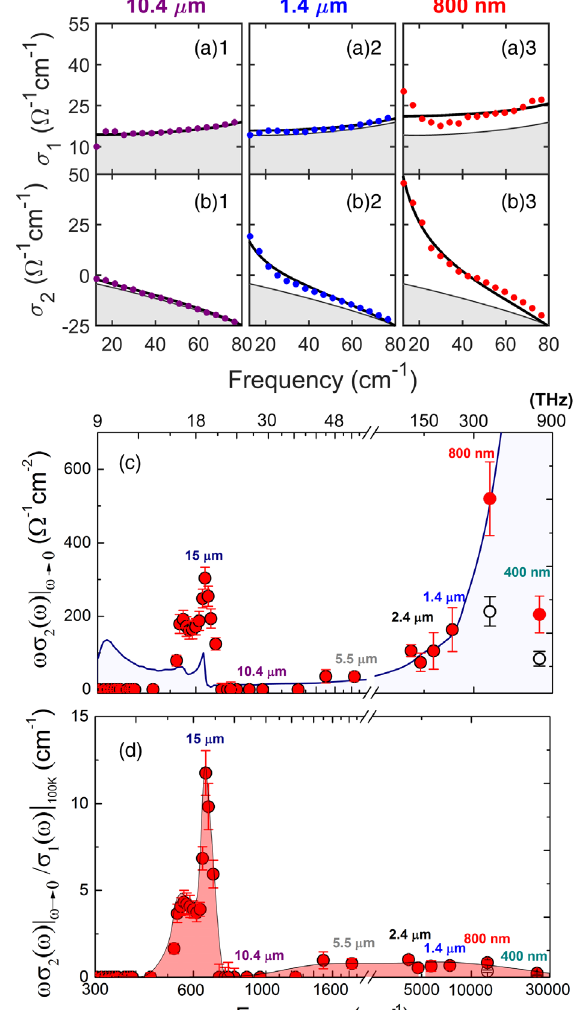
FIG. 6. Transient c -axisopticalresponse inducedbyhigh-energy charge excitation at T ¼ 100 K. (a),(b) Complex optical conduc- tivity σ 1 ð ω Þ þ i σ 2 ð ω Þ , measured at equilibrium (gray) and at τ ≃ 0 . 5 ps time delay (colored circles) after excitation at three different pump wavelengths with approximately 8 mJ = cm 2 pump fluence. The black solid lines are fits to the transient spectra performed with either a simple Drude-Lorentz model for normal conductors [(a)1, (b)1] or a model describing the response of a Josephson plasma [(a) 2, (b)2, (a)3, (b)3] (see Supplemental Material [20] for more details on the fitting procedure). (c) Pump frequency dependence of the superconducting response, represented by the low-frequency limit ωσ ð ω Þj 2 ω → 0 (red circles). The equilibrium optical conductivity σ equil ð ω Þ is shown as a blue line. (d) Normalized response 1 pump ωσ ð ω Þj = σ equil ð ω Þ (red circles). The gray line is a multi- 2 ω → 0 1 pump < 300 THz were taken with Lorentzian fit. All data for ω pump constant pump fluence ( 8 mJ = cm 2 ) and peak electric field ¼ ( 3 MV = cm) at a fixed pulse duration of 600 fs. At λ pump 800 nm and λ ¼ 400 nm, for which the pump pulses were pump 100 fs long, we report data points taken at both 8 mJ = cm 2 (approximately 7 MV = cm, red circles) and 1 . 5 mJ = cm 2 (approx- imately 3 MV = cm, empty circles), keeping either the excitation fluence or peak electric field at the same